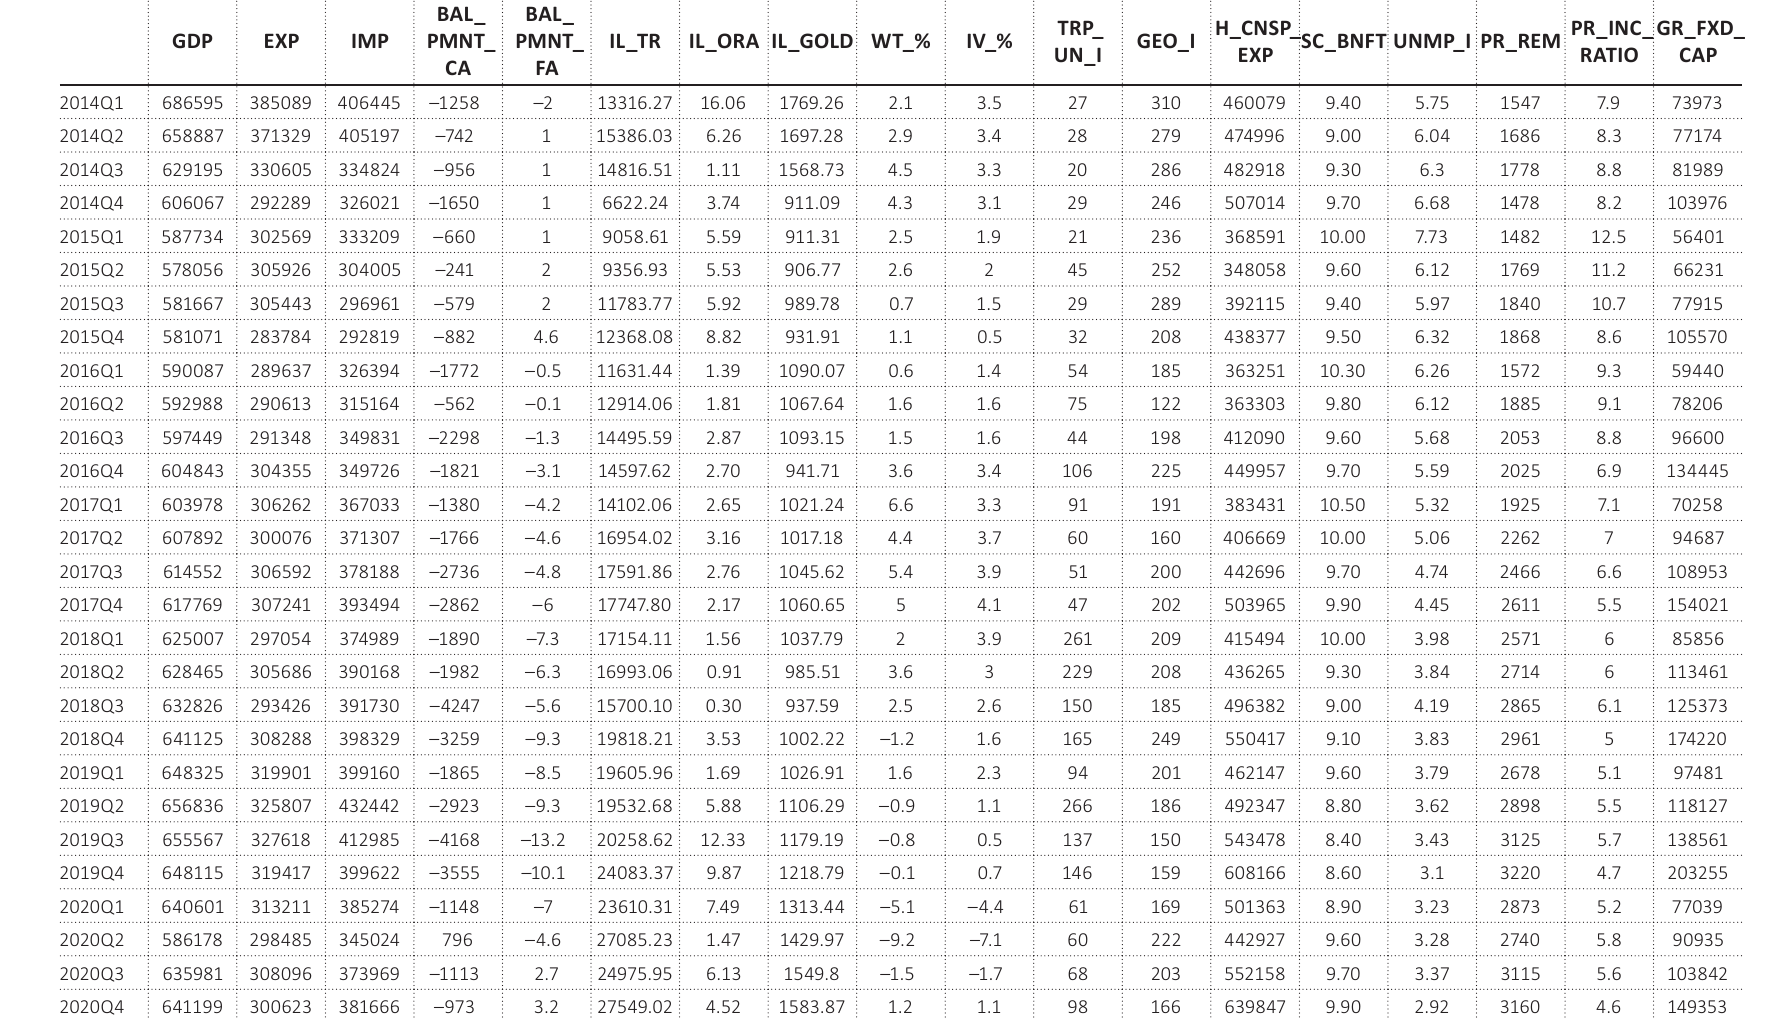
Table A1. Input data for causal analysis of state economic security